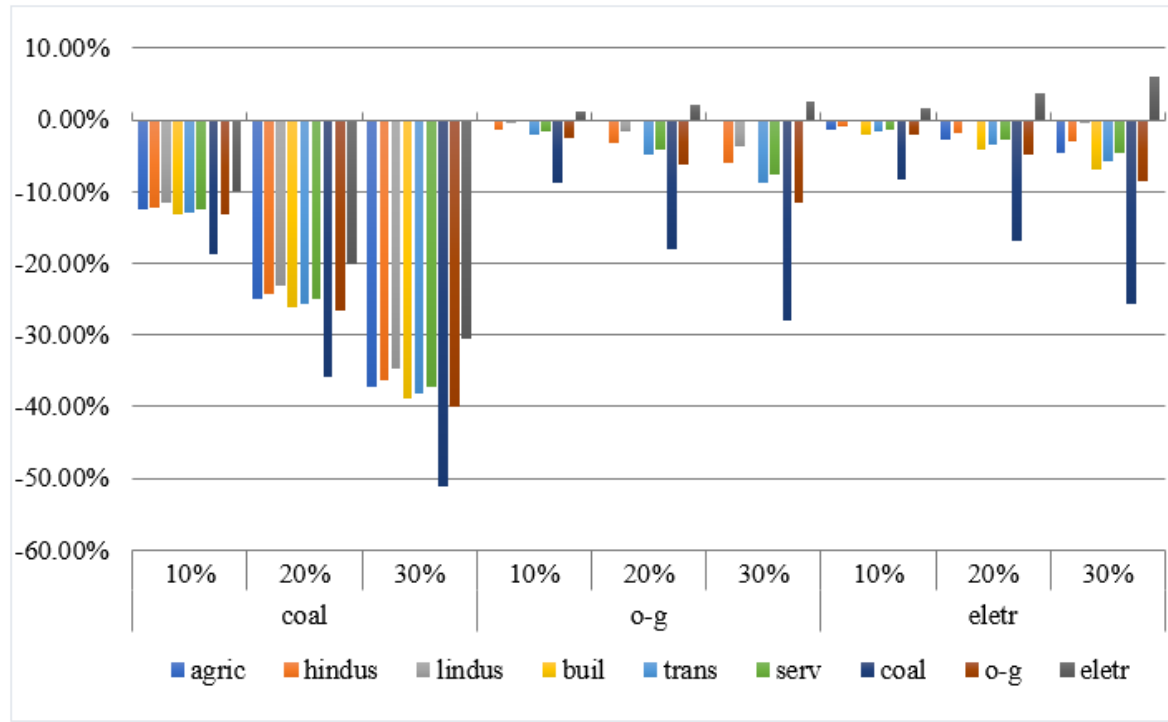
Figure 2. Consumption of each sector. The nine sectors and their classification are as follows: Agriculture (agric), Heavy industry (hindus), Light industry (lindus), Building industry (buil), Transportation industry (trans), Service industry (serv), Coal industry (coal), Oil and gas industry (o-g), Electricity industry (eletr).